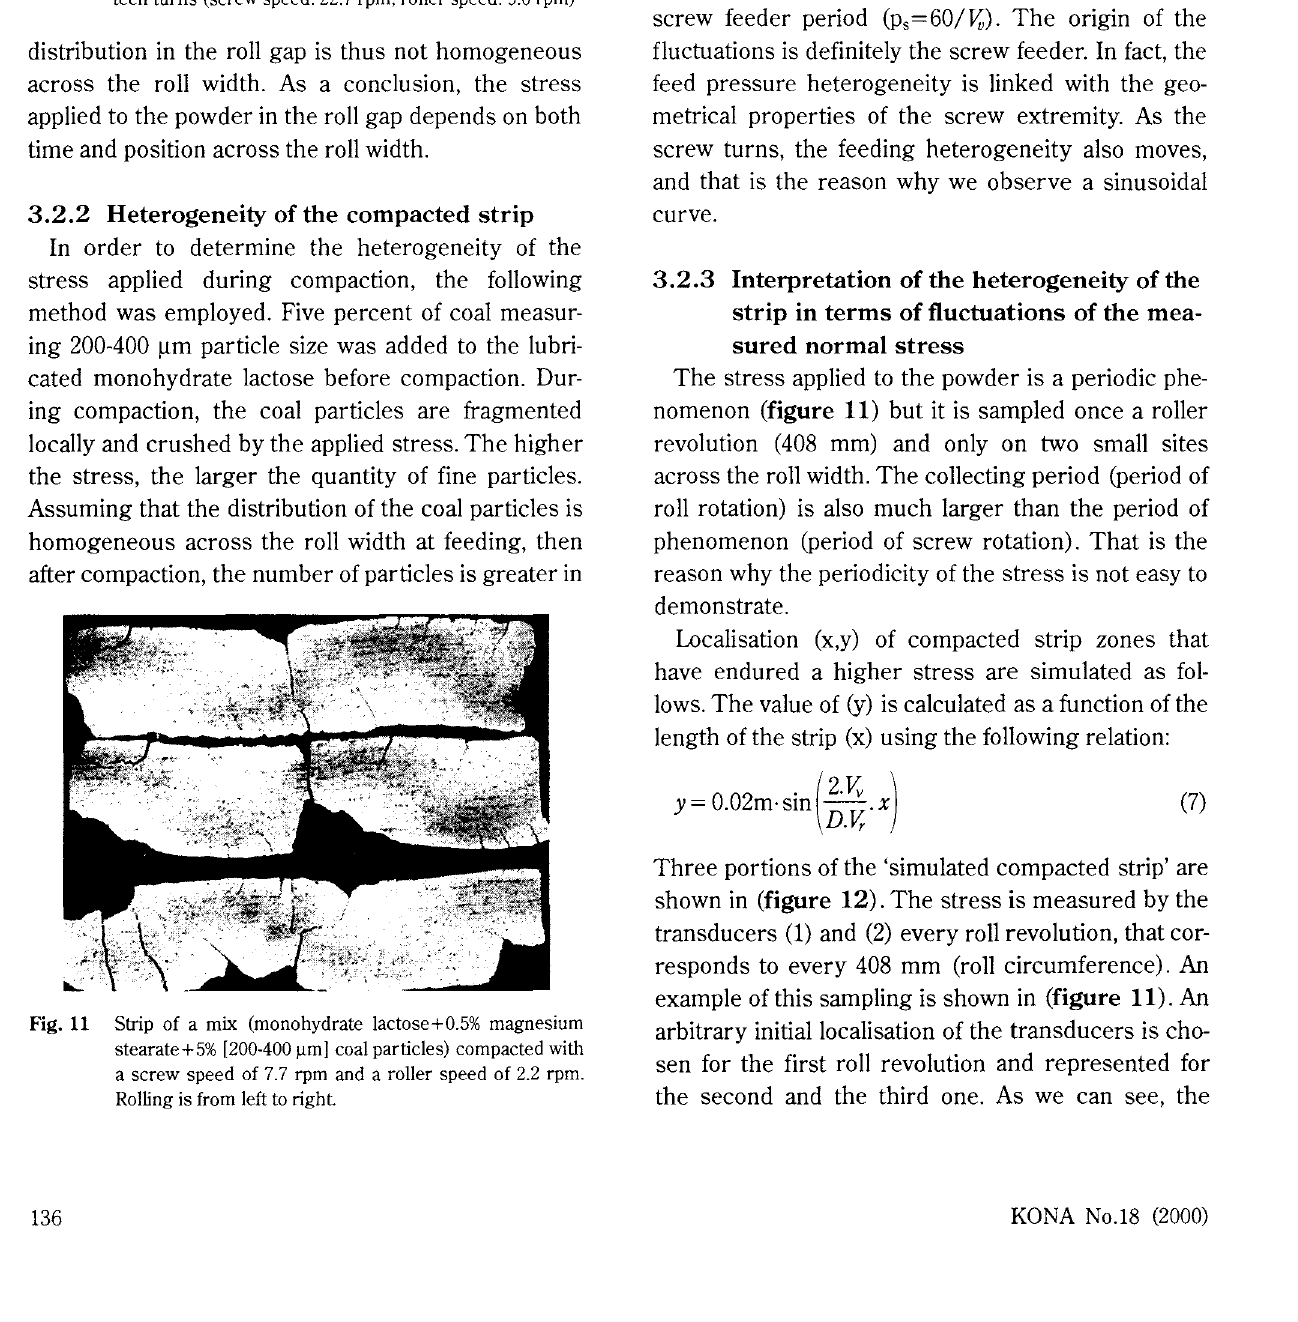
Fig. 10 Profiles of normal stress recorded simultaneously by both piezoelectric transducers (1) and (2) during four teen turns (screw speed: 22.7 rpm, roller speed: 9.0 rpm)